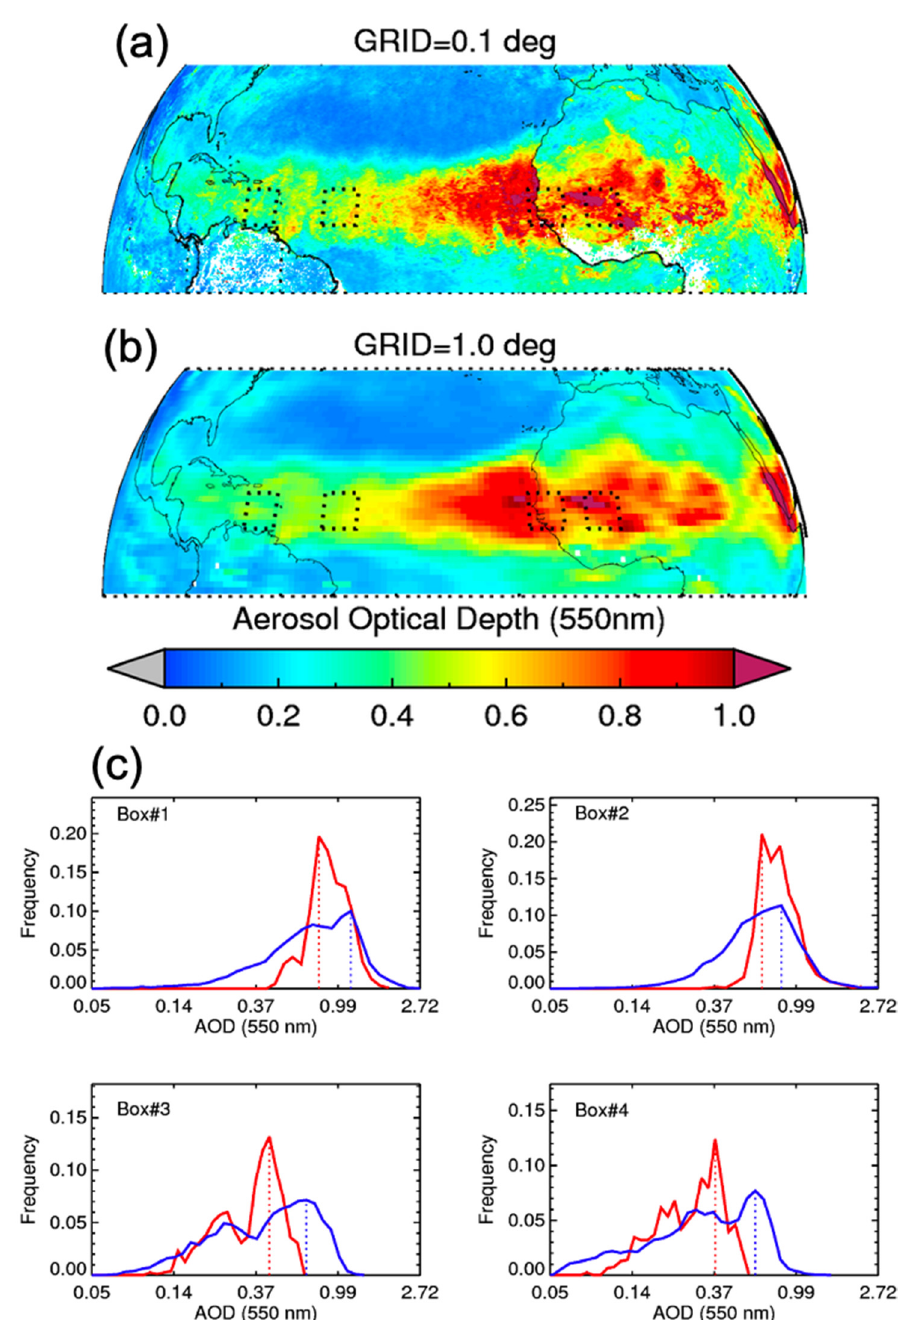
Figure 10. Application of HRG AOD to monitor dust transport across the Atlantic Ocean during June 2018. Map ( a ) shows mean HRG AOD from both MODIS-Aqua and MODIS-Terra from June 18 to July 3, 2018; ( b ) same as ( a ) but at the reduced spatial resolution of 1 × 1 degree (CRG), and ( c ) the four histograms representing four 10 × 10 degree boxes on the path of dust plume as it originates over North Africa and is transported over the Atlantic Ocean and finally reaching the American continents. The Red line on the histogram is using CRG, whereas blue is from HRG AOD data.